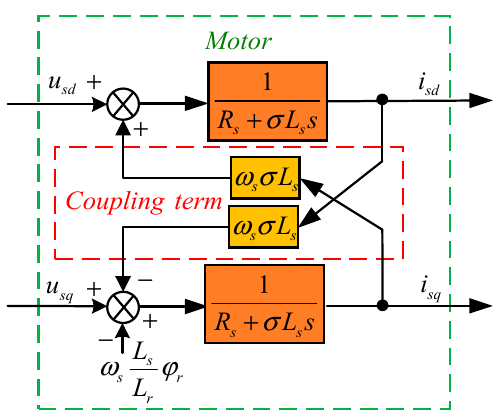
Figure 4. Coupling structure of an asynchronous motor.